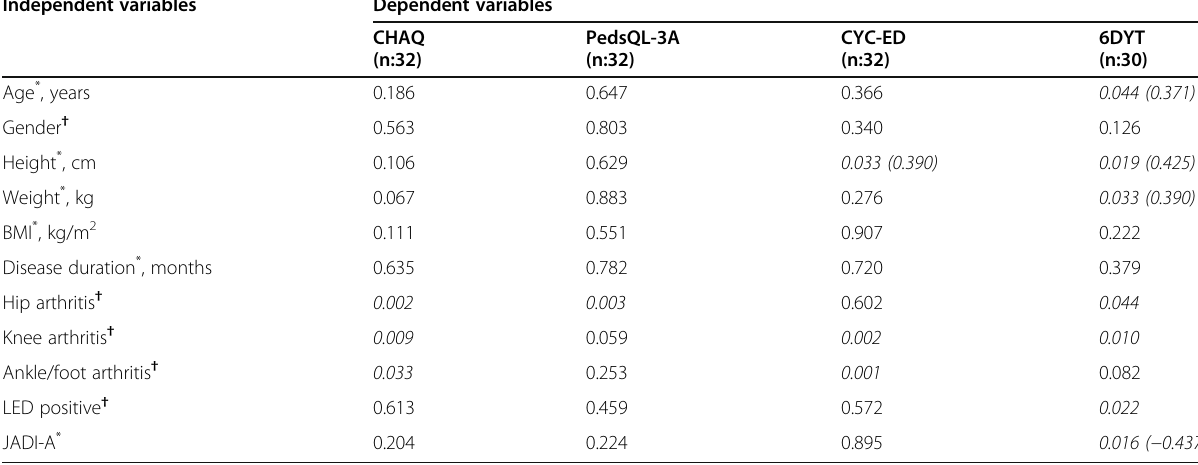
Table 2 Associations between the dependent and independent variables Independent variables